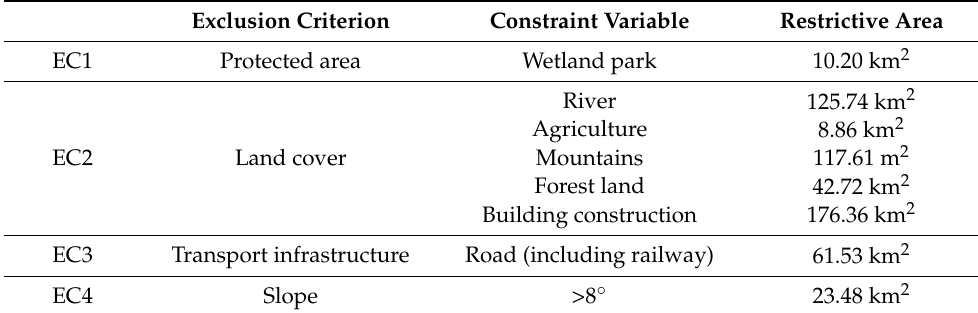
Figure 5. Constrained layer of Wuhan’s central city. Table 5. Detailed data information of various exclusion criteria.